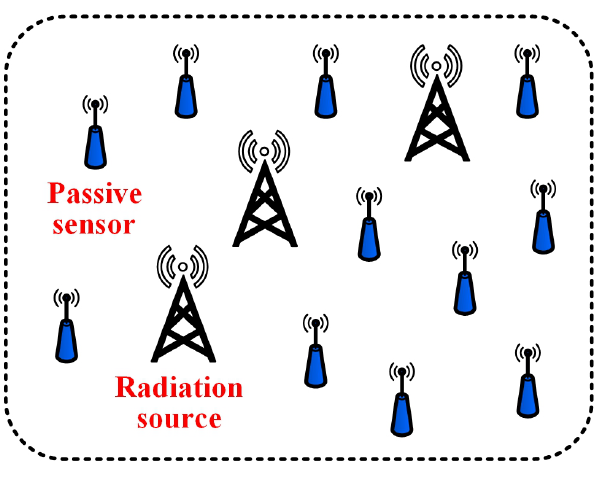
Figure 1. The scenario of multiple sources